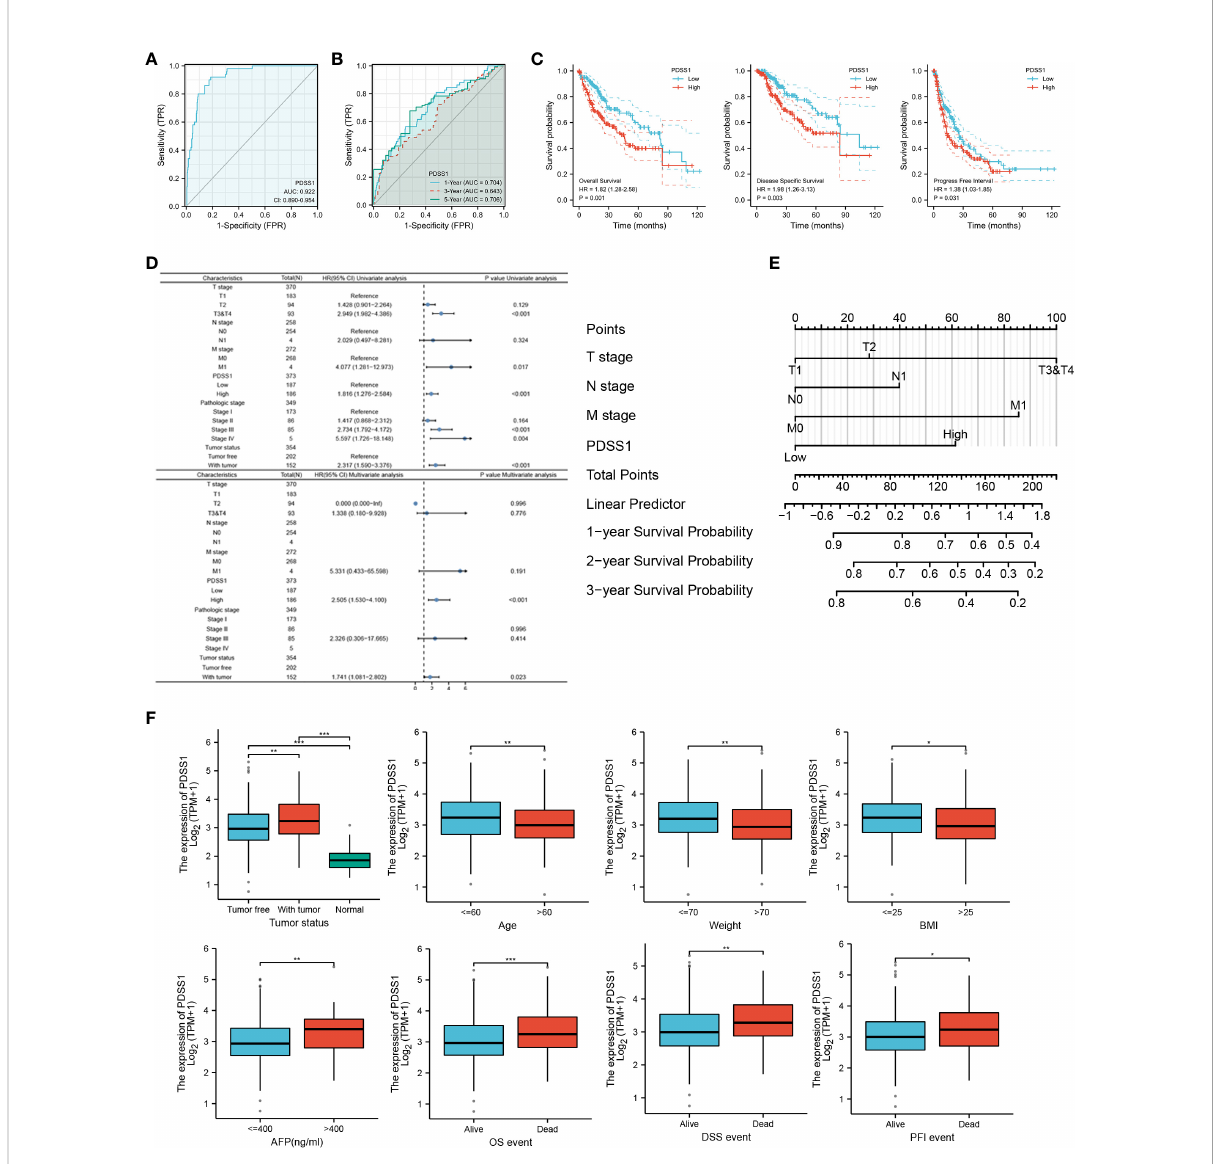
FIGURE 2 Expression of PDSS1 was correlated with prognosis of HCC patients. (A, B) ROC curve to test the value of PDSS1 to identify HCC. (C) overall survival, disease speci fi c survival and progress free interval in HCC using GEPIA database. (D) Univariate and multivariate Cox regression analysis identi fi ed the association of PDSS1 with the clinical factors with OS in TCGA database. (E) Nomogram map showed the correlation between PDSS1 expression and prognosis. (F) Correlation between expression of PDSS1 and clinic-pathological features. * p < 0.05, ** p < 0.01, *** p <